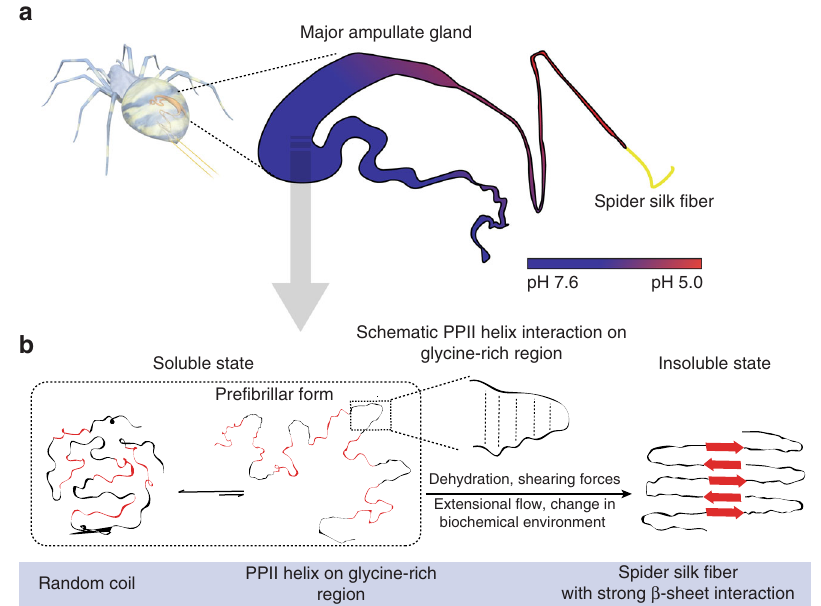
Fig. 5 Proposed mechanism of β -sheet formation of spider dragline silk. a Spider major ampullate gland displays a strong pH gradient (reproduced with permission 70 , Copyright 2017, American Chemical Society). b Two major structural populations of spider dragline silk proteins, random coil, and PPII helix in the glycine-rich region, occur in soluble form. The presence of the PPII helix in the glycine-rich region is proposed as a soluble pre fi brillar form of spider dragline silk. The polyalanine region is shown in red, and the glycine-rich region is shown in black. Schematic illustration of PPII helix interaction in the glycine-rich region is shown in the box. In response to dehydration, shearing forces, extensional fl ow and changes in the biochemical environment, this pre fi brillar form will generate spider dragline fi bers through strong β -sheet